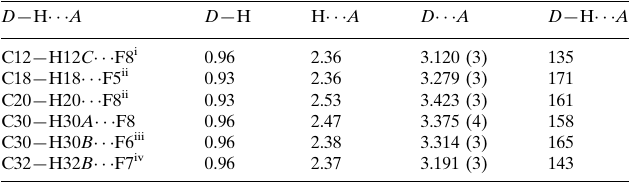
Hydrogen-bond geometry (A˚ , (cid:3)